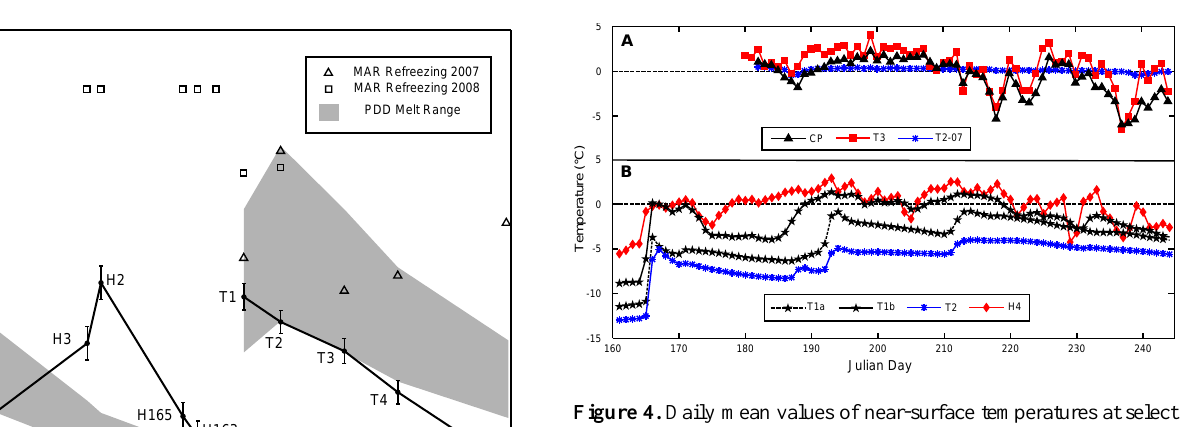
Figure 4. Daily mean values of near-surface temperatures at select sites. Some sites are not shown for figure clarity but in all cases were very similar to the sites that are included. (a) 2007 sites. (b) 2008 sites. The near-surface temperature is calculated as the average of the temperatures output by the upper four thermistors (1m) in the temperature strings at each site.